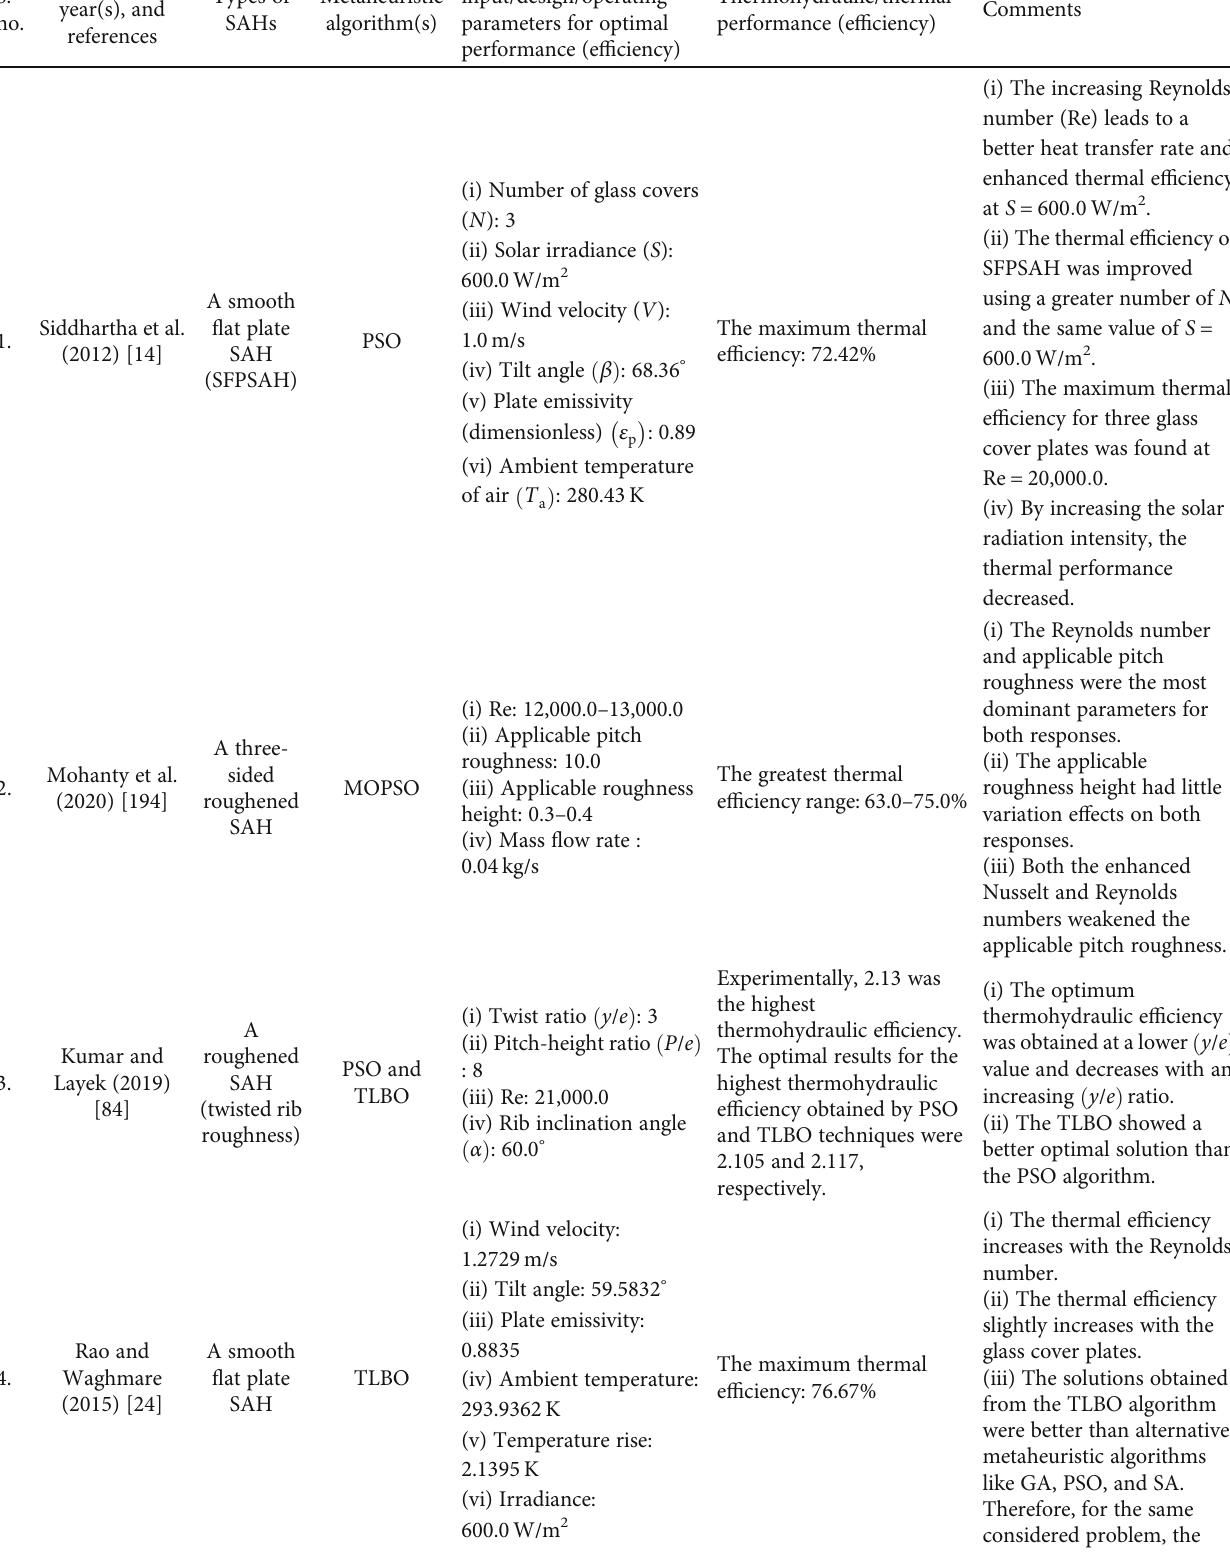
Table 4: Comparison of thermal or thermohydraulic performance of SAHs using various metaheuristic algorithms for SAH optimization.